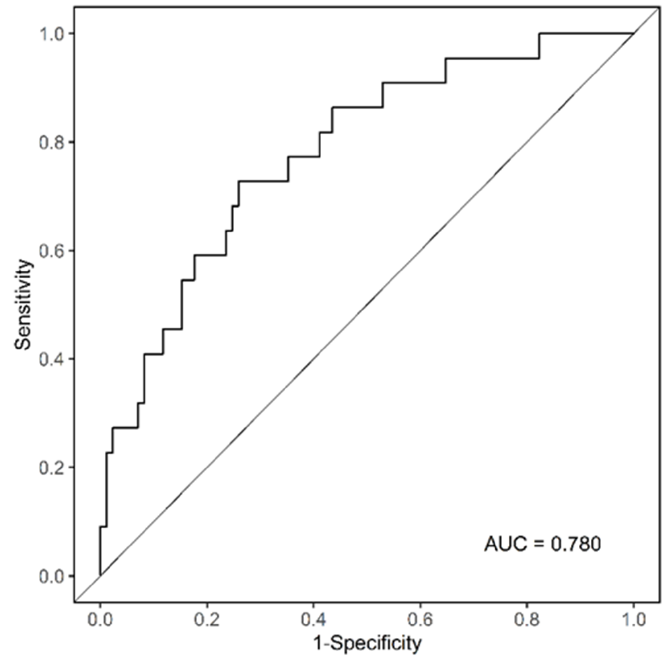
Figure 3. Analysis of the ROC curve to prove the reliability of the